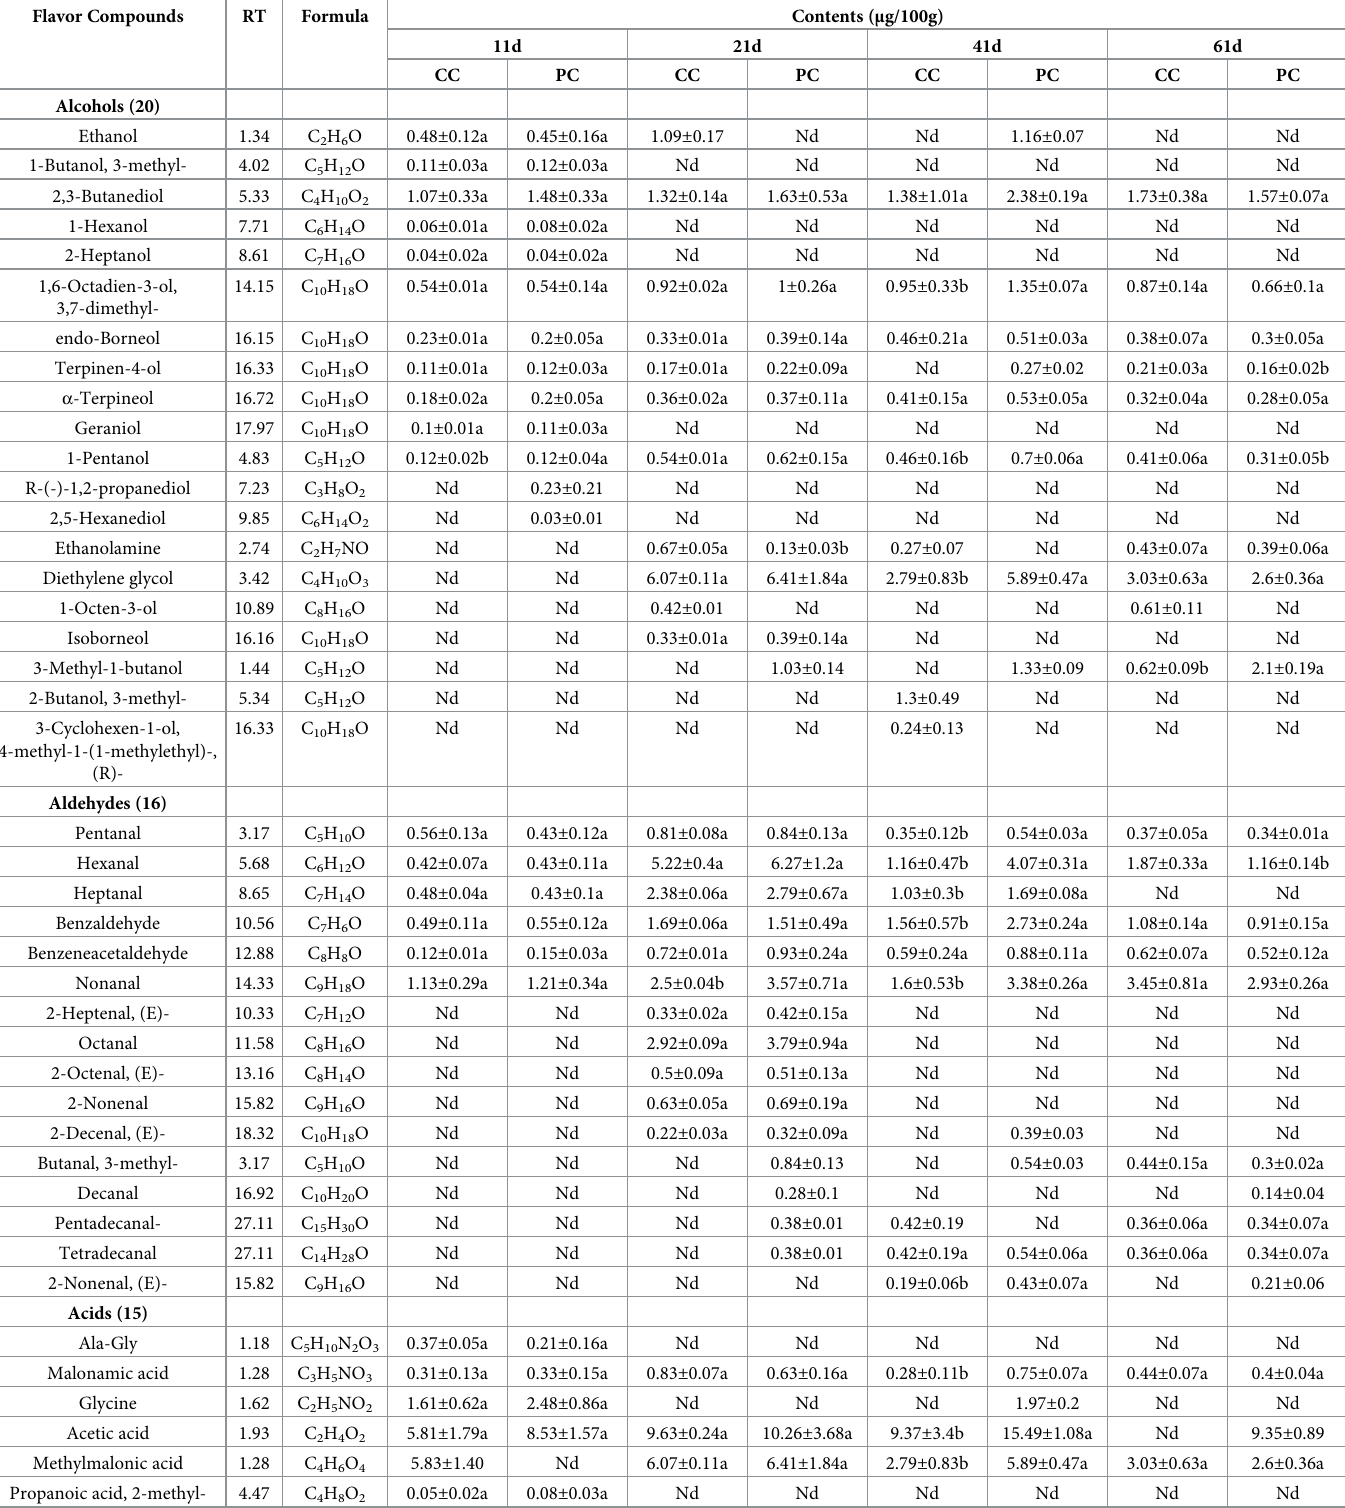
Table 6. Volatile flavour compounds identified and quantified ( μ g/100g) in fermented sausages by GC–MS during storage. Flavor